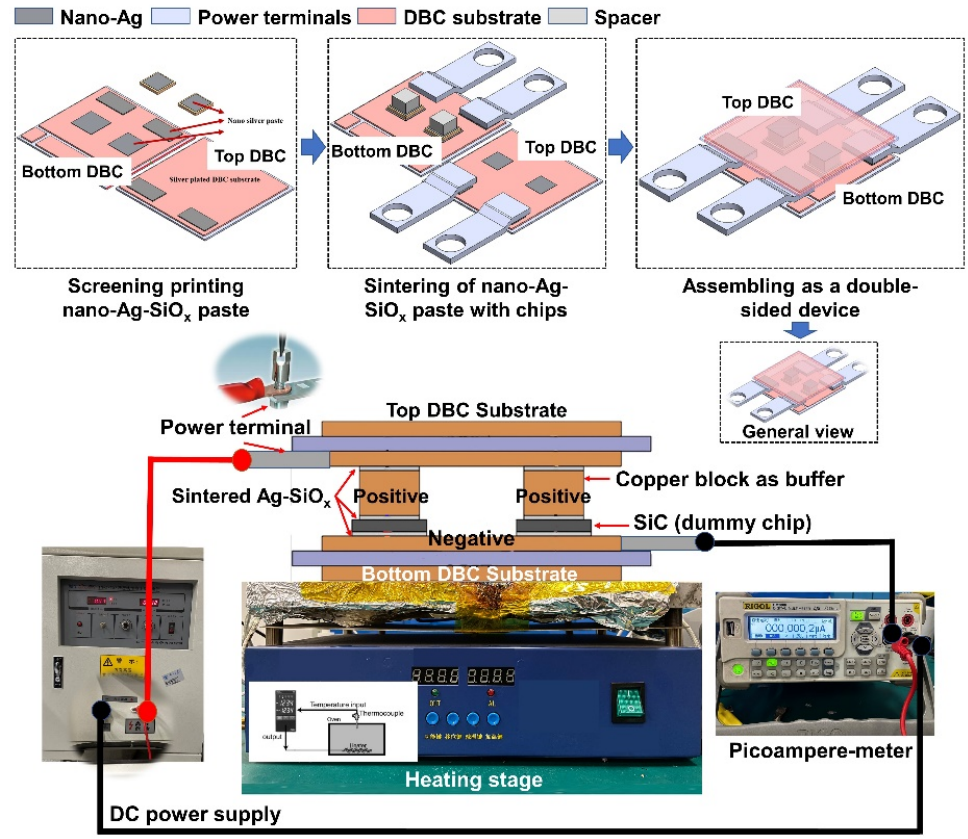
Figure 2. Fabrication process of the DSC demonstration and verification of electrochemical migration resistance for a DSC device using sintered nano-Ag-SiO x as die attachment.